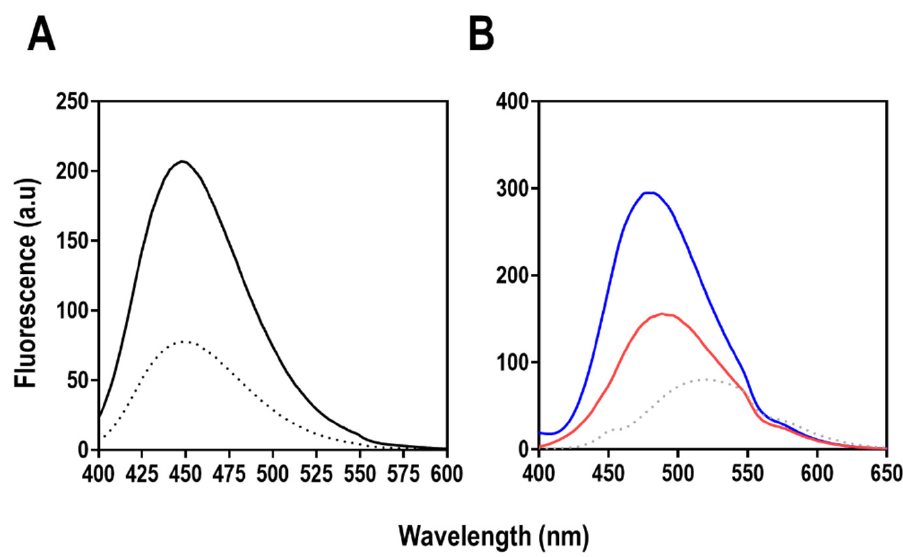
Figure 17. Tertiary structure analysis of ClpK using extrinsic fluoresence spectroscopy. ( A ) Fluores- cence emission spectra of mant-ATP in the presence (bold spectrum) or absence (dotted line spectrum) of 2.0 µ M ClpK. The fluorescent nucleotides (10 µ M) were excited at 355 nm and emissions were collected between 400 and 600 nm. Each spectrum represents an average of five accumulated spectra from three independent experiments. ( B ) ANS fluorescence spectroscopy of ClpK. ClpK (2.0 µ M) was incubated (20 ◦ C, 30 min) with ANS alone (red spectrum) and ANS in the presence of 0.2 mM ATP (blue spectrum). The dotted line spectrum represents spectrum of free (unbound) ANS in the assay buffer (10 mM sodium phosphate pH 7.4 and 5 mM MgCl 2 ). The fluorescence emission was recorded in the wavelength region 400–650 nm after exciting the samples at 390 nm. The bandwidths were set at 5 nm for excitation and emission. The path length of the sample was 1 cm. Each spectrum represents an average of five accumulated spectra from three independent experiments. Here, a.u is arbitrary